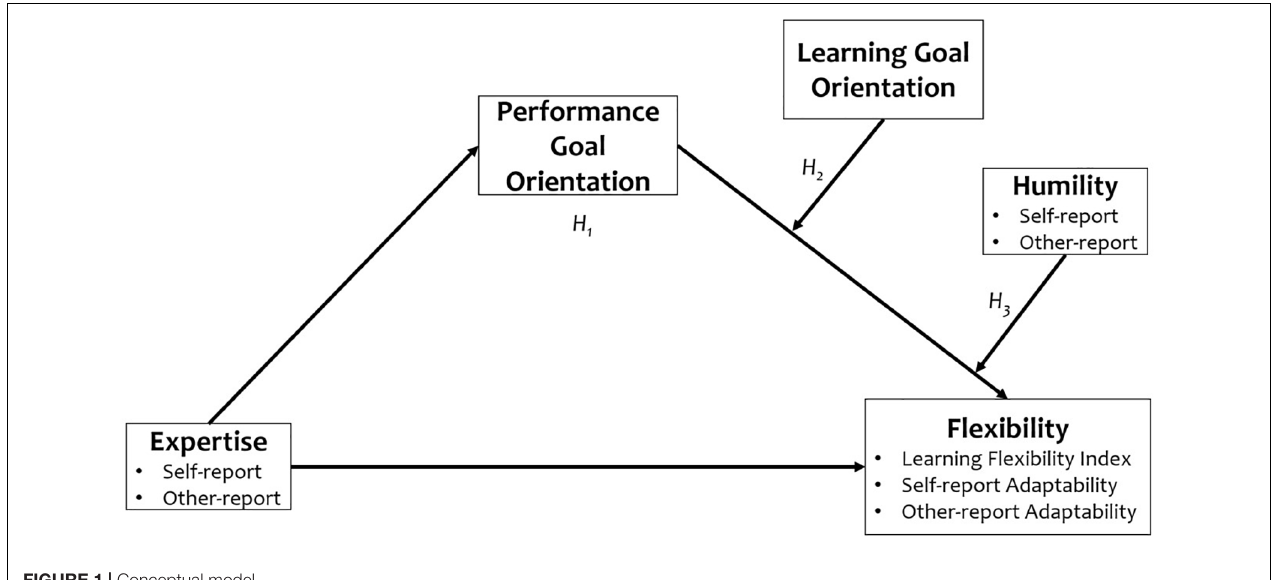
FIGURE 1 | Conceptual